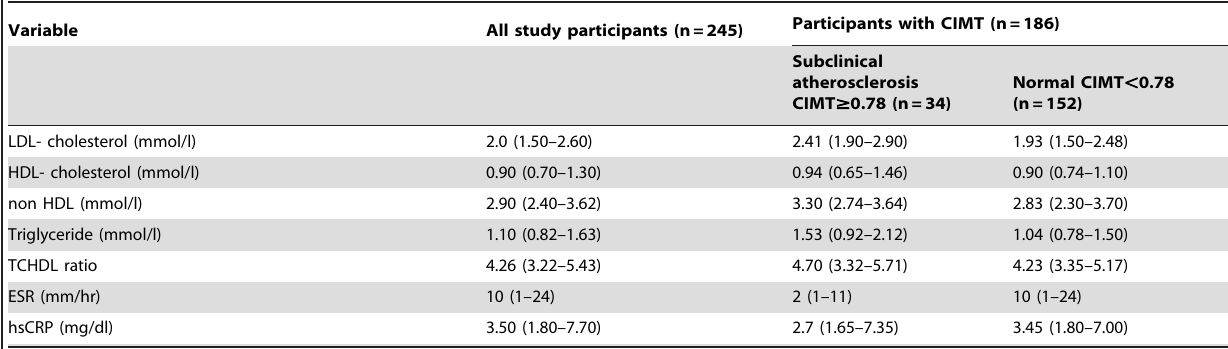
Variable All study participants